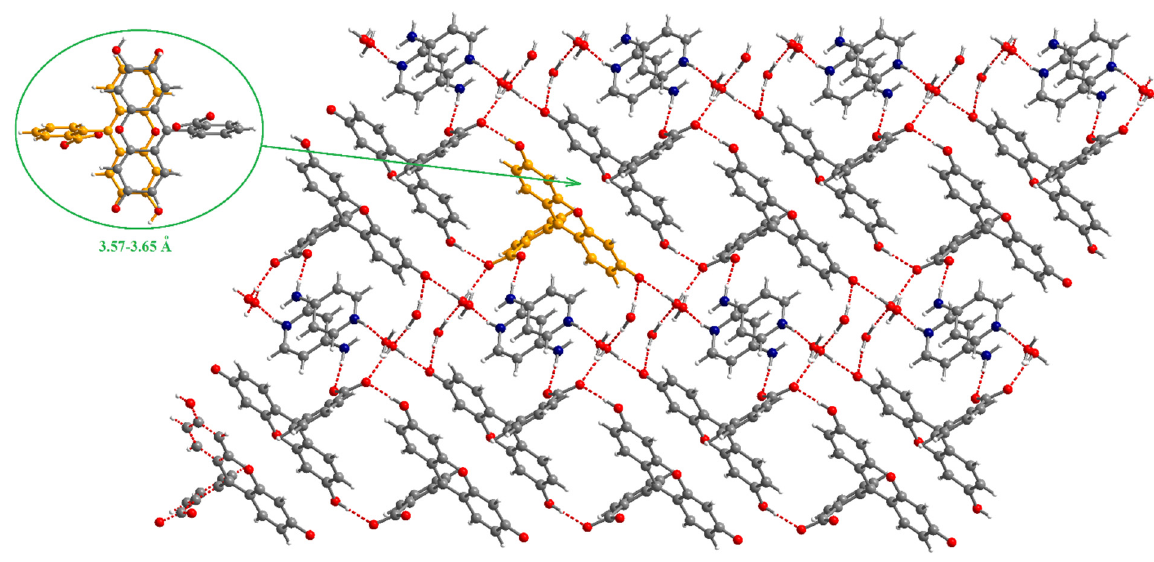
Figure 12. View of a packing diagram in crystal 6 . The inset shows a detail of the π−π interactions established within the supramolecular dimers formed by the fluorescein monoanions.